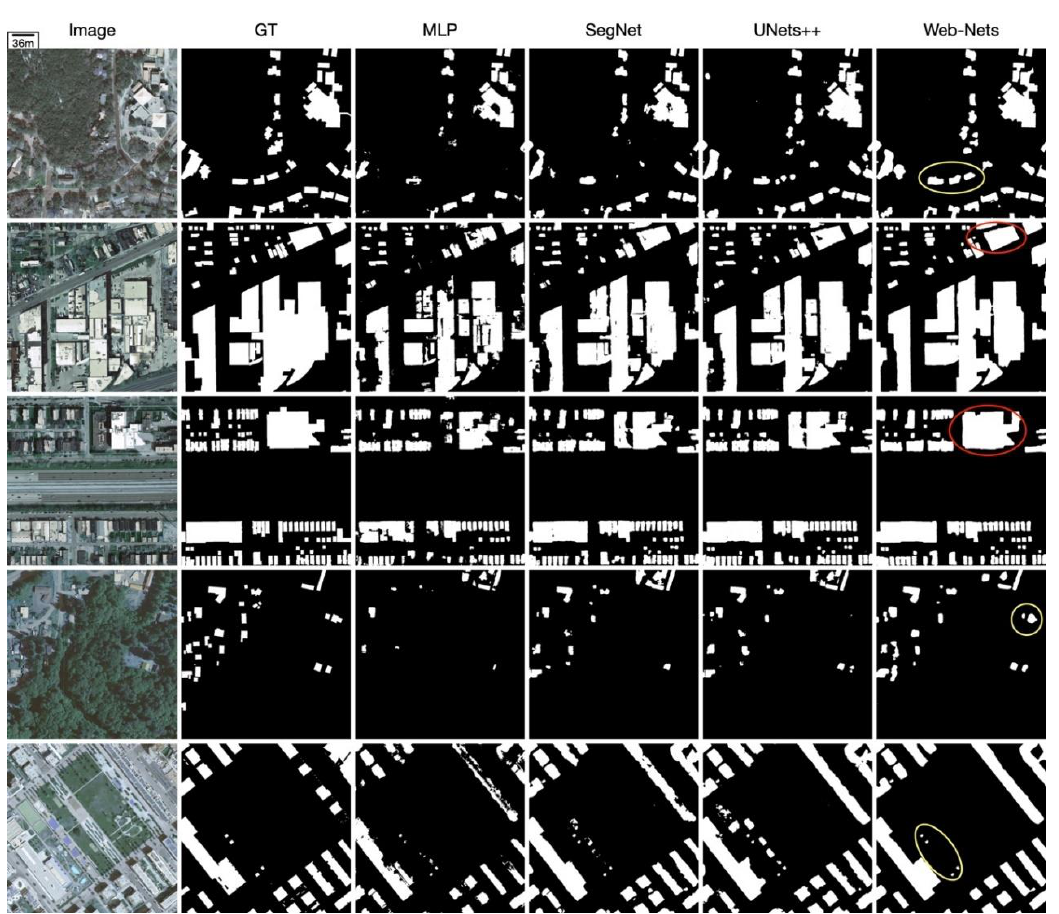
Figure 10. The images in each row are randomly chosen from Austin, Chicago, Kitsap, Tyrol, and Vienna, and the patch size is 1000×1000. Columns 2-6 are the ground truth and prediction maps from MLP, SegNet, Unet++, and Web-Net, respectively. The areas in red circles are correct predictions in shadowed areas, and the yellow circles are correct classifications where other models fail. Table 6. Numerical Results among